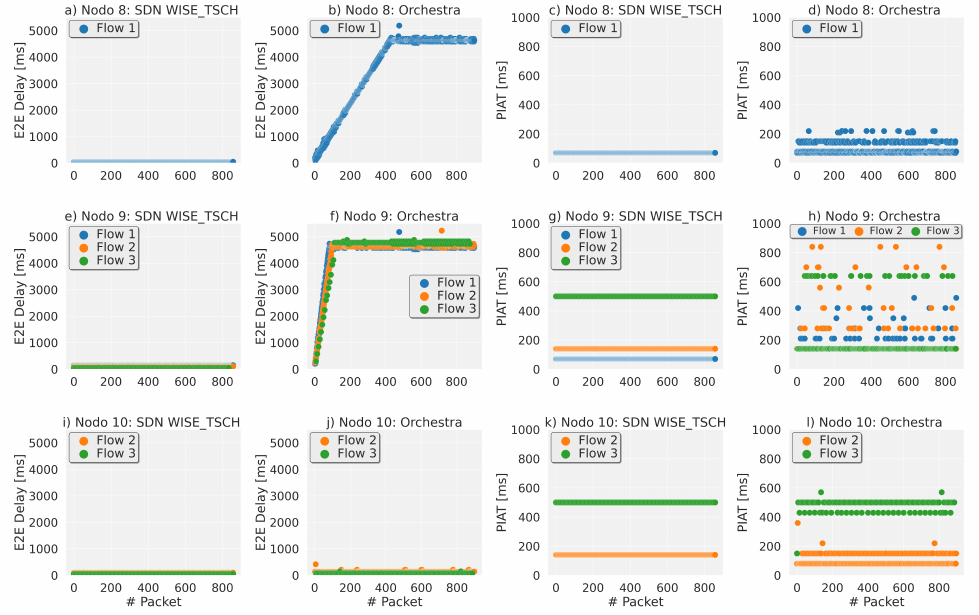
Figure 10. End-to-End Delay and Packet Inter-arrival time in testbed for SDN WISE-TSCH and Orchestra.